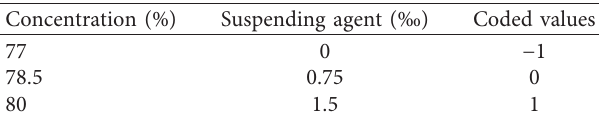
Table 2: The actual and coded values of the experimental factors. Concentration (%) Suspending agent (‰) Coded